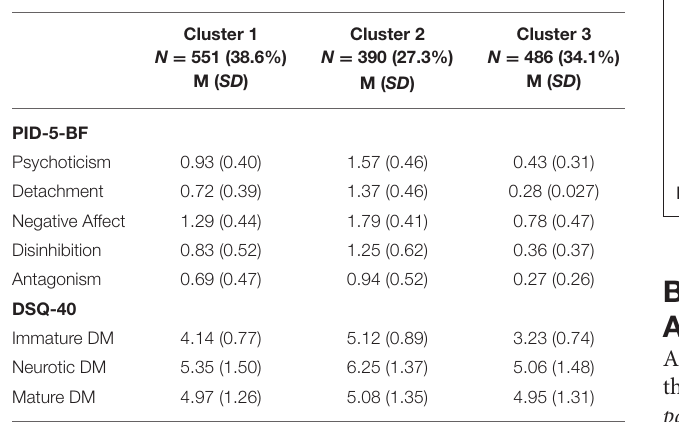
TABLE 2 | Two-step cluste analysis.